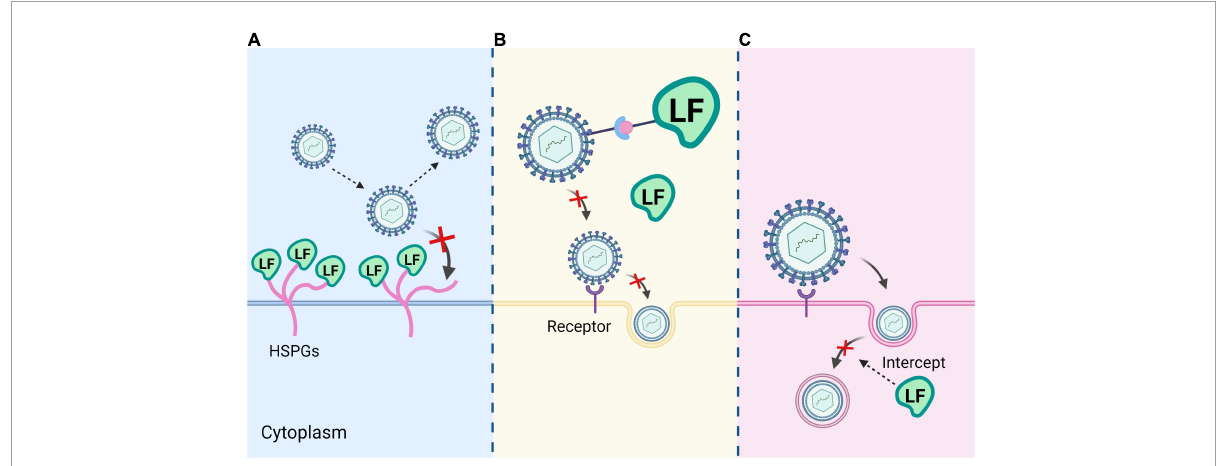
FIGURE4 Three mechanisms of Lf antivirus. (A) Lf binds to heparan sulfate proteoglycans (HSPGs) on the host cell surface. (B) Lf binds directly to viral proteins and inhibits viral adsorption to target cells. (C) Lf interferes with intracellular transport of the virus and blocks the transmission of the viral genome to the